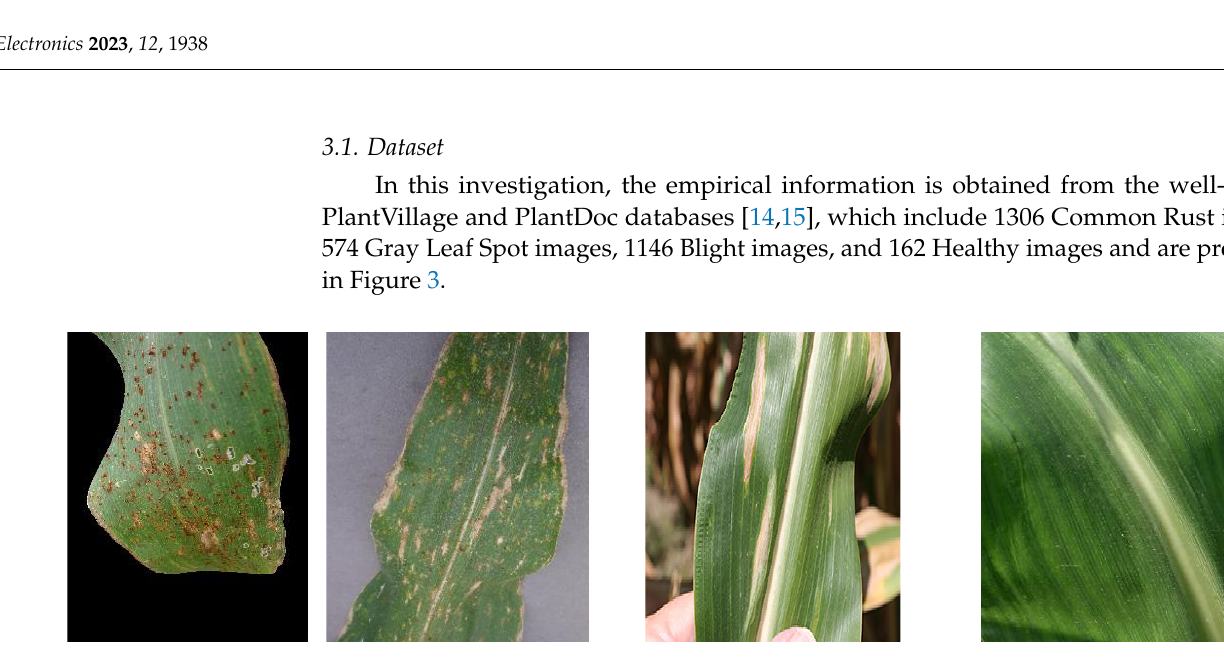
Figure 2. Flow Diagram of the proposed framework.